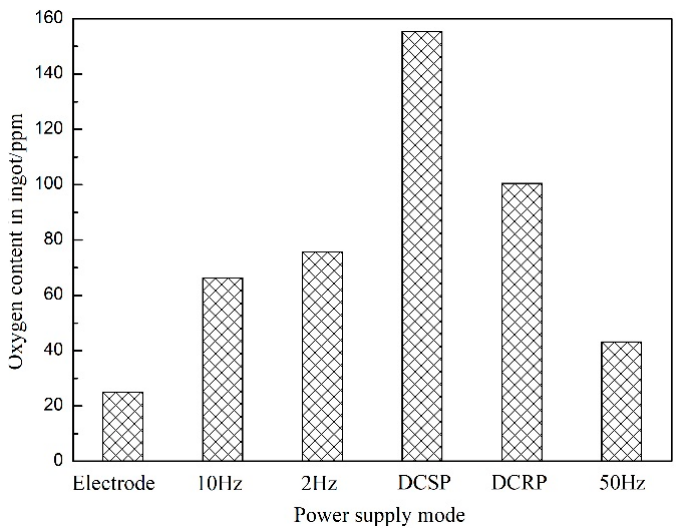
Figure 3. Oxygen content in ingots with different power supply